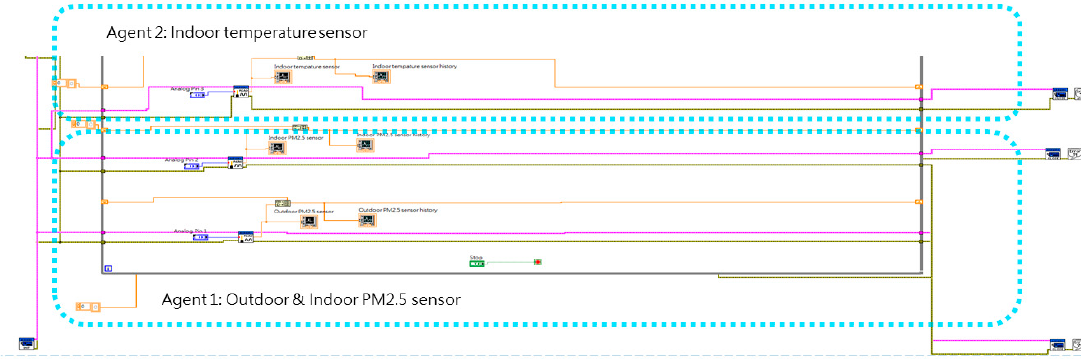
Figure 14. Sensor portion of multi-agent program.